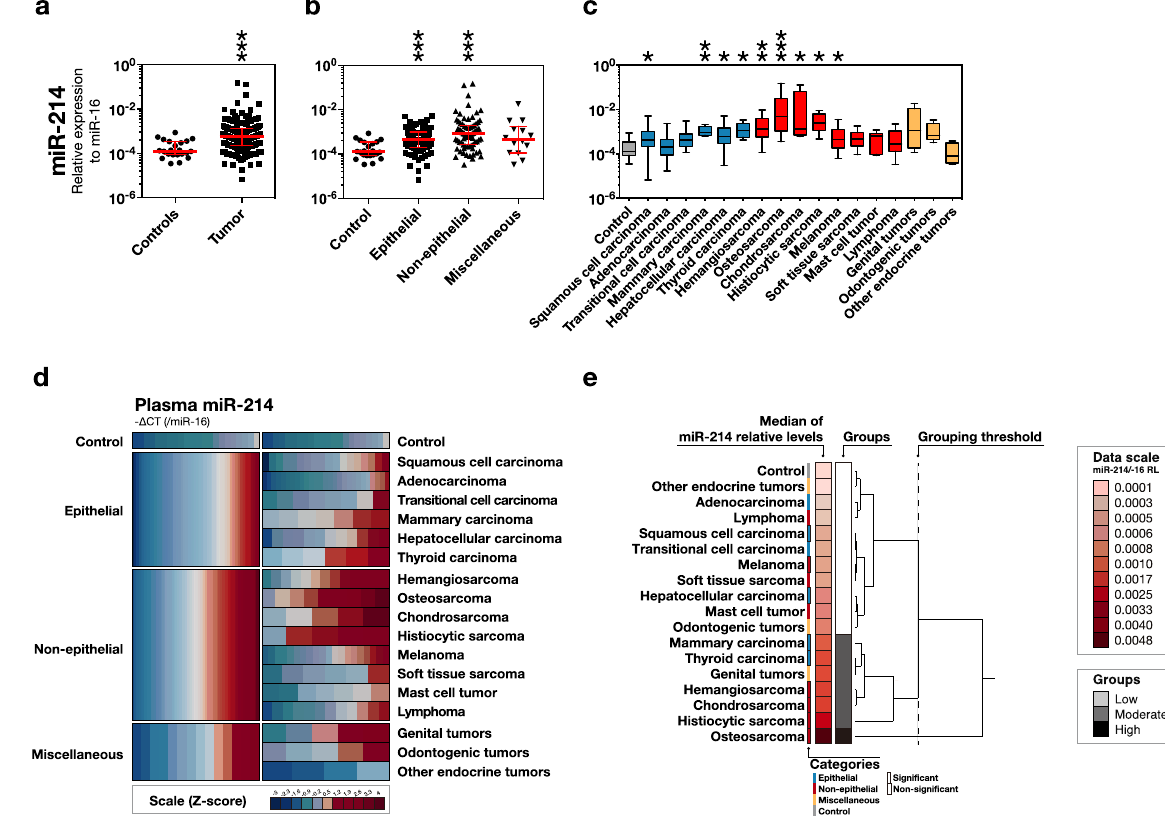
Figure 2. Circulating miR-214 profiles for canine tumours. Circulating miR-214 levels ( − ∆ CT, relative to circulating miR-16 levels) were mainly increased in non-epithelial tumours, especially the sarcomas. (a) Swarm plot of circulating miR-214 levels comparing tumour and control. *** P < 0.001 (Mann-Whitney U test) (b) Swarm plot of circulating miR-214 levels comparing the groups of epithelial, non-epithelial, miscellaneous tumours, and controls. * P < 0.05, *** P < 0.001 (Steel’s Test) (c) Box plot of circulating miR-214 levels comparing the subcategories. * P < 0.05, ** P < 0.01, *** P < 0.001 (Steel’s Test). (d) Heatmap overview of circulating miR-214 levels. (e) Hierarchical cluster analysis of circulating miR-214 levels. The representative values used were the medians of miR-214 levels. The dendrogram was illustrated by Ward’s method, and categorised into 3 groups based on the indicated